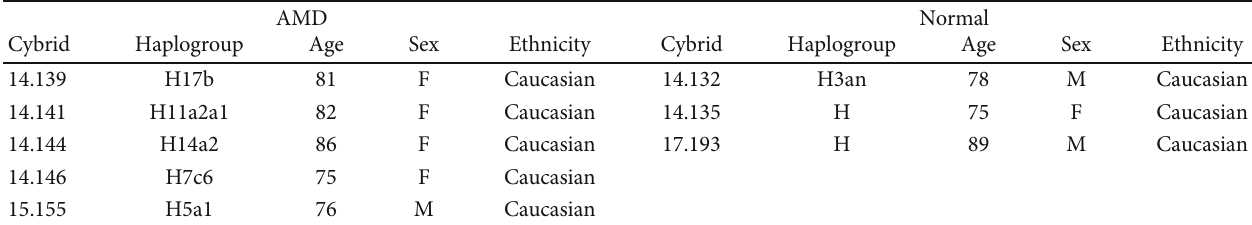
Table 1: Demographics of the AMD and normal cybrids used in the cellular viability and gene expression experiments. AMD Normal Cybrid Haplogroup Age Sex Ethnicity Cybrid Haplogroup Age Sex Ethnicity 14.139 H17b F Caucasian 14.132 H3an Caucasian Caucasian 14.135 Caucasian Caucasian Caucasian